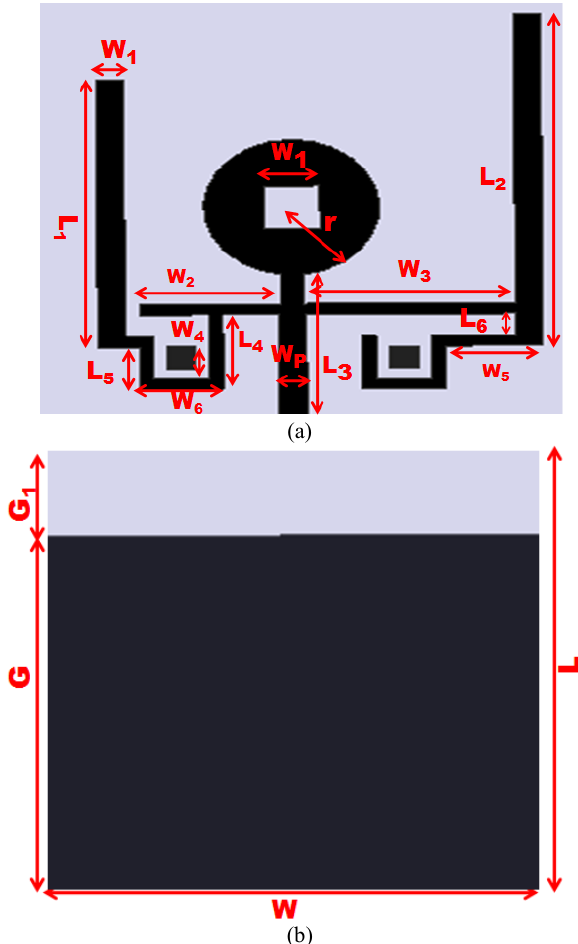
Figure 1 . Structure of the proposed configuration (a) front part (b) back part.